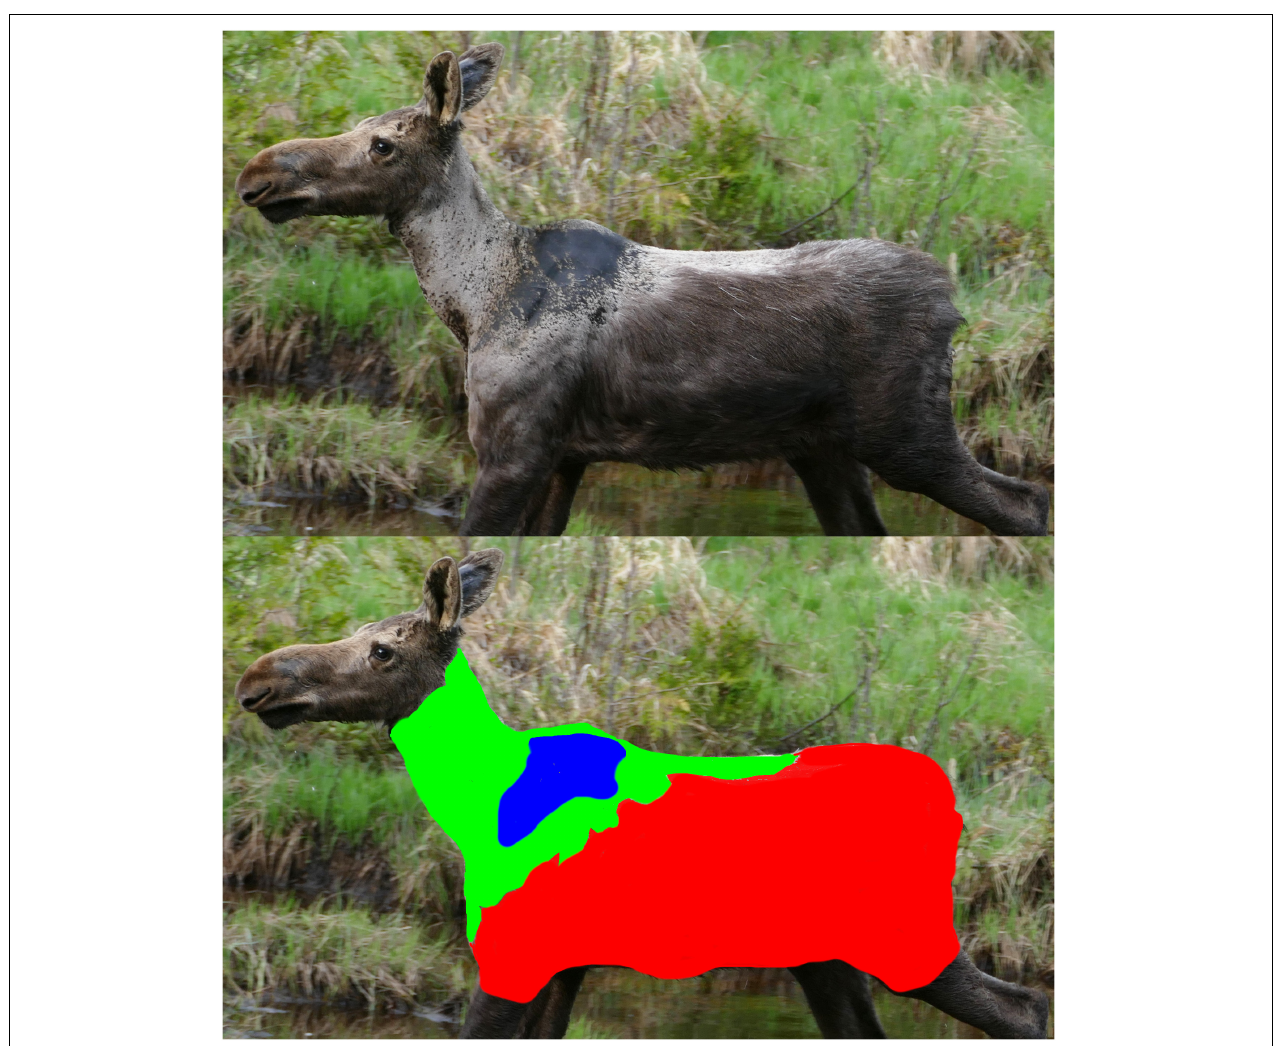
FIGURE 1 | Example profile image of a moose used to estimate hair loss on the animal’s neck and torso due to winter ticks. Hair loss occurs when moose groom themselves to get rid of winter ticks and was estimated from images of individual moose. In the upper image, undamaged hair is brown, damaged guard hairs are light gray/white in color, and areas where the hair is completely missing (i.e., bare skin) are dark brown or black in color (see also Supplementary Figure 4 ). The lower image is identical to the one above, except that the three hair categories are indicated with block colors (red is undamaged hair, green is damaged hair, and blue is missing hair). In all statistical analyses, the response variable was the logit transformation of the proportion of hair lost or damaged. That proportion was calculated as the sum of the green and blue areas divided by the sum of the red, green and blue